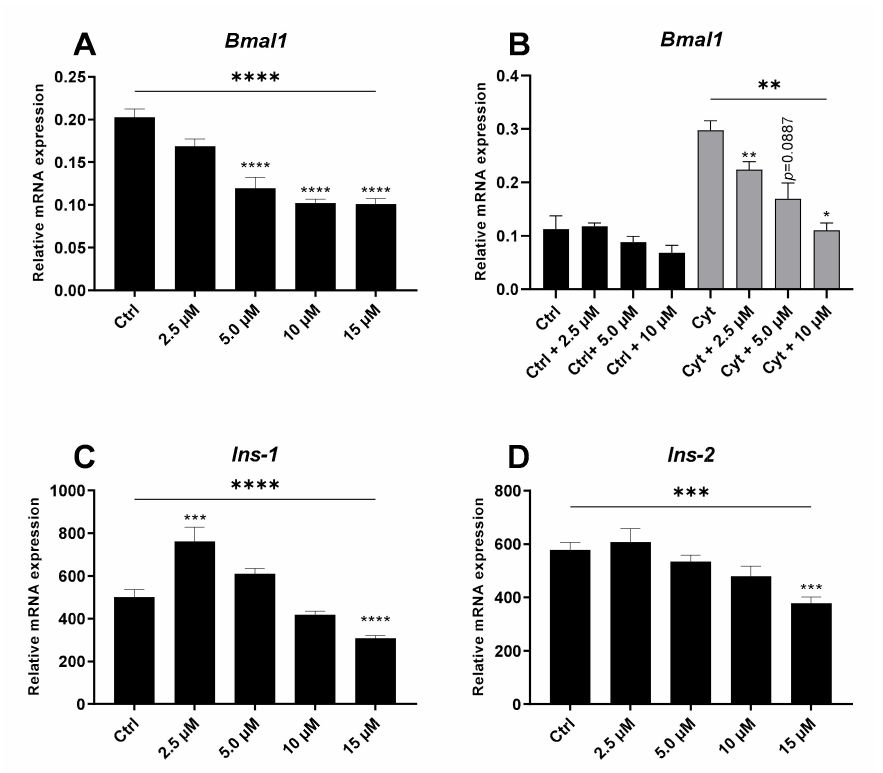
Figure 4. SR9009 dose- dependently decreases brain and muscle arnt-like 1 ( Bmal1 ) and insulin 1/2 ( Ins-1/2 ) expression in non-synchronized INS-1 cells. INS-1 cells were exposed to increasing doses of SR9009 alone for 24 h ( A – D ) or in combination with 150 pg/mL mouse IL-1 β + 0.1 ng/mL rat IFN- γ (Cyt) for 12 h ( B ). Relative mRNA expression is calculated using Hprt1 as reference gene. Values are mean ± SEM ( n = 3–9). Statistics are one-way ANOVA with p -values represented by symbols above the line and with Dunnett’s corrected multiple comparisons to Ctrl (black bars) or to Cyt (gray bars). Significance levels were annotated as follows: * = p -value < 0.05, ** = p -value < 0.01, *** = p -value < 0.001, **** = p -value <